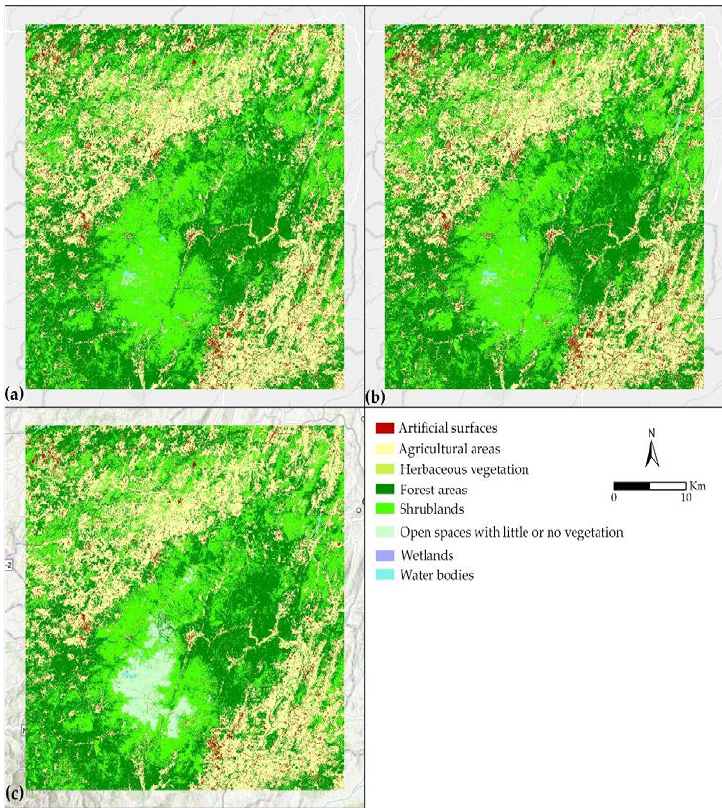
Figure 12. Classification results for study area B obtained with the training samples TS0 ( a ), TS1 ( b ) and TS2 ( c ), extracted, respectively, from TD0, TD1 and TD2. Remote Sens. 2020 , 12 , x FOR PEER REVIEW